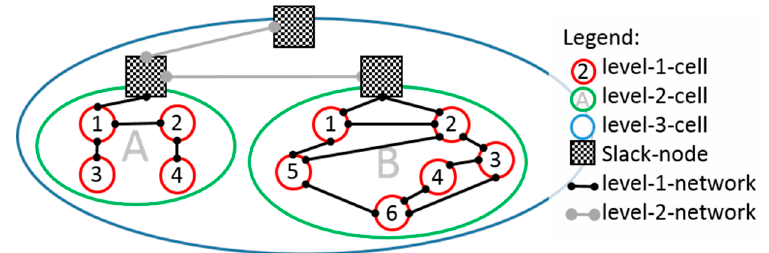
Figure 2. Implementation of the cellular approach in HyFlow.